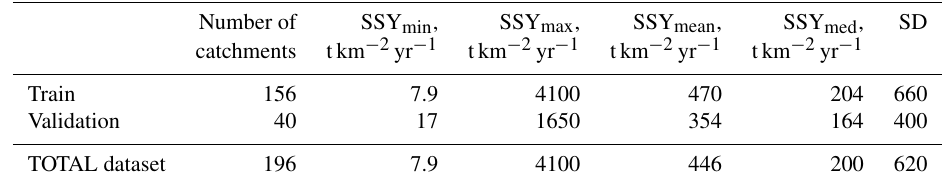
Table 2. Ranges and characteristics of the observed suspended sediment yields and the generated training and validation datasets (without outliers).